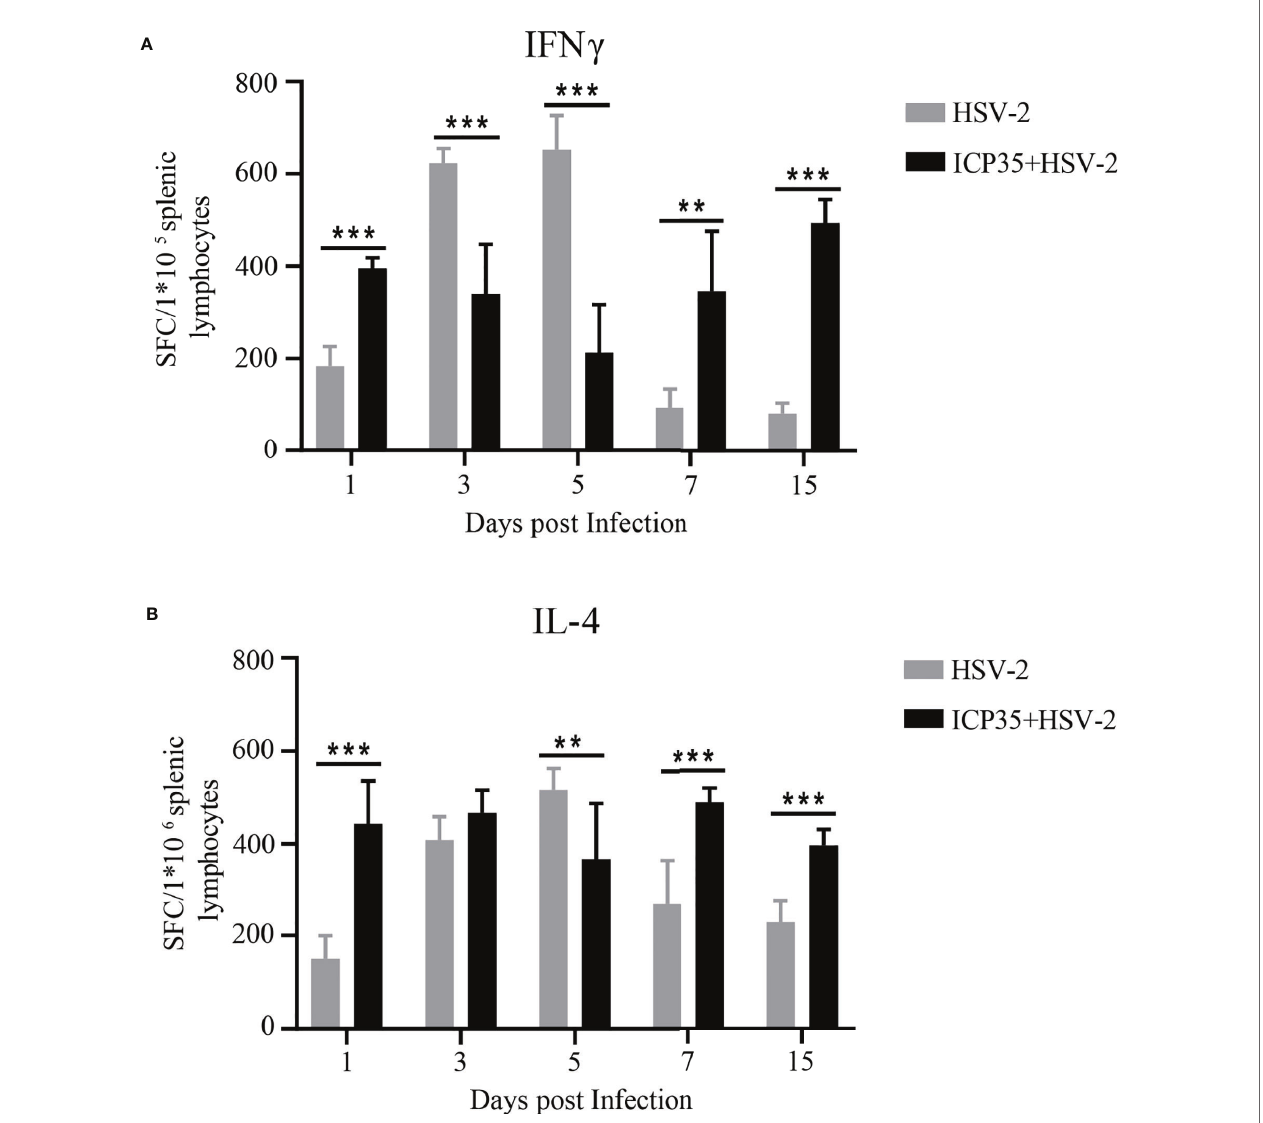
FIGURE 2 | ICP35 elicited speci fi c T cell response in mice. (A) The ELISPOT analysis of ICP35 elicited IFN- g -secreting T cell responses within the splenic lymphocyte population in the immunized and control groups. Samples were run in duplicate. (n=3). (B) The ELISPOT analysis of ICP35 elicited IL-4- secreting T cell responses within the splenic lymphocyte population in the immunized and control groups. Samples were run in duplicate. (n=3). HSV-2, indicates the animal immunized with Al (OH) 3 and challenged with HSV-2 groups; ICP35+HSV-2, indicates the animal immunized with ICP35 and challenged with HSV-2 groups;. SFC, indicates the Spot-forming Cells. **P<0.01,